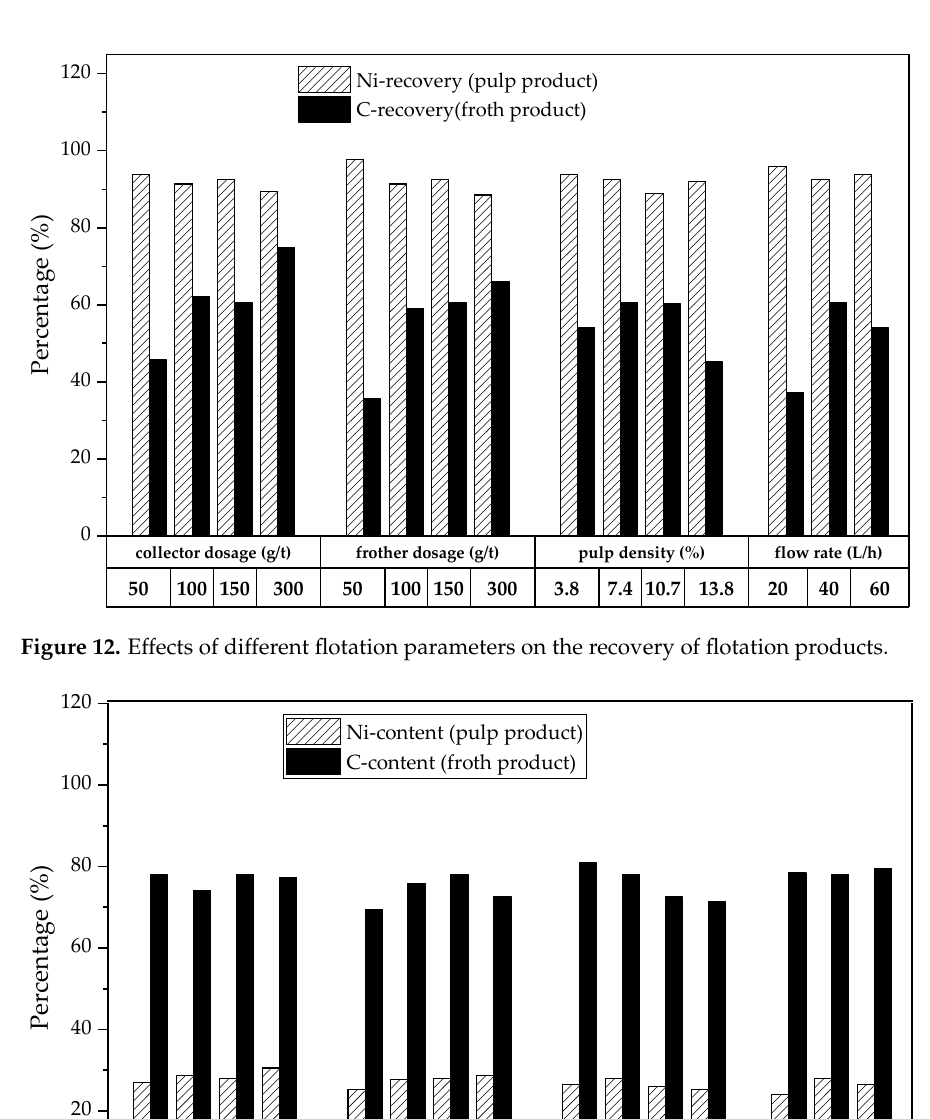
Figure 14. An example flow chart with the rapid analysis method integrated into the process.